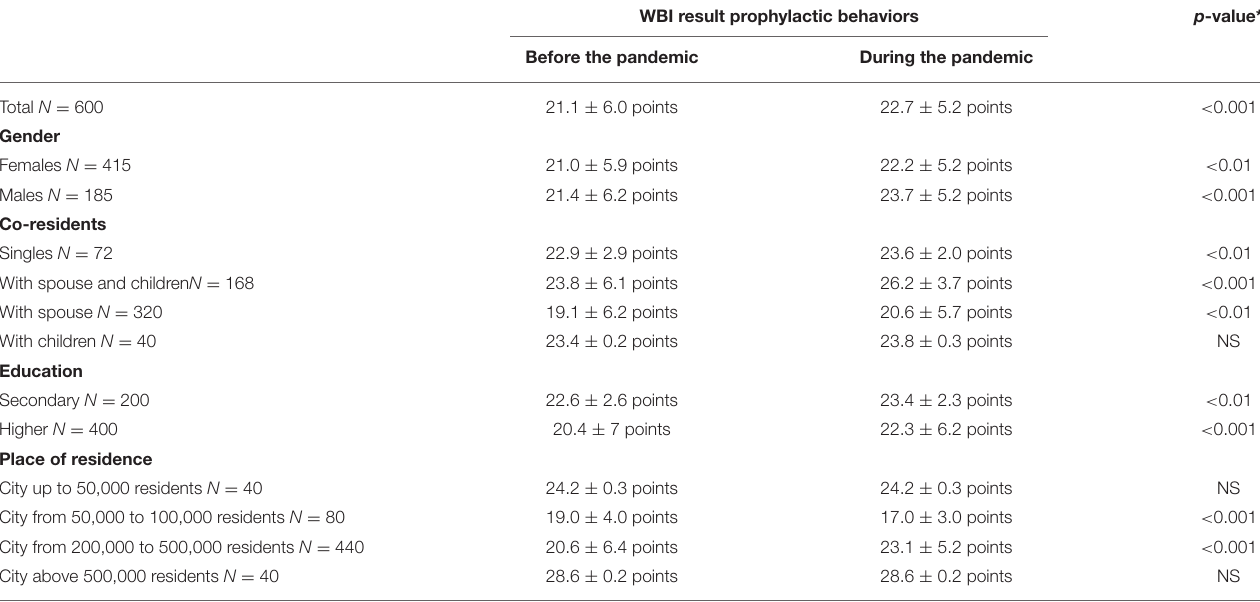
TABLE 7 | Assessment of prophylactic behaviors among the respondents before and during the pandemic by gender, education, co-residents, and place of